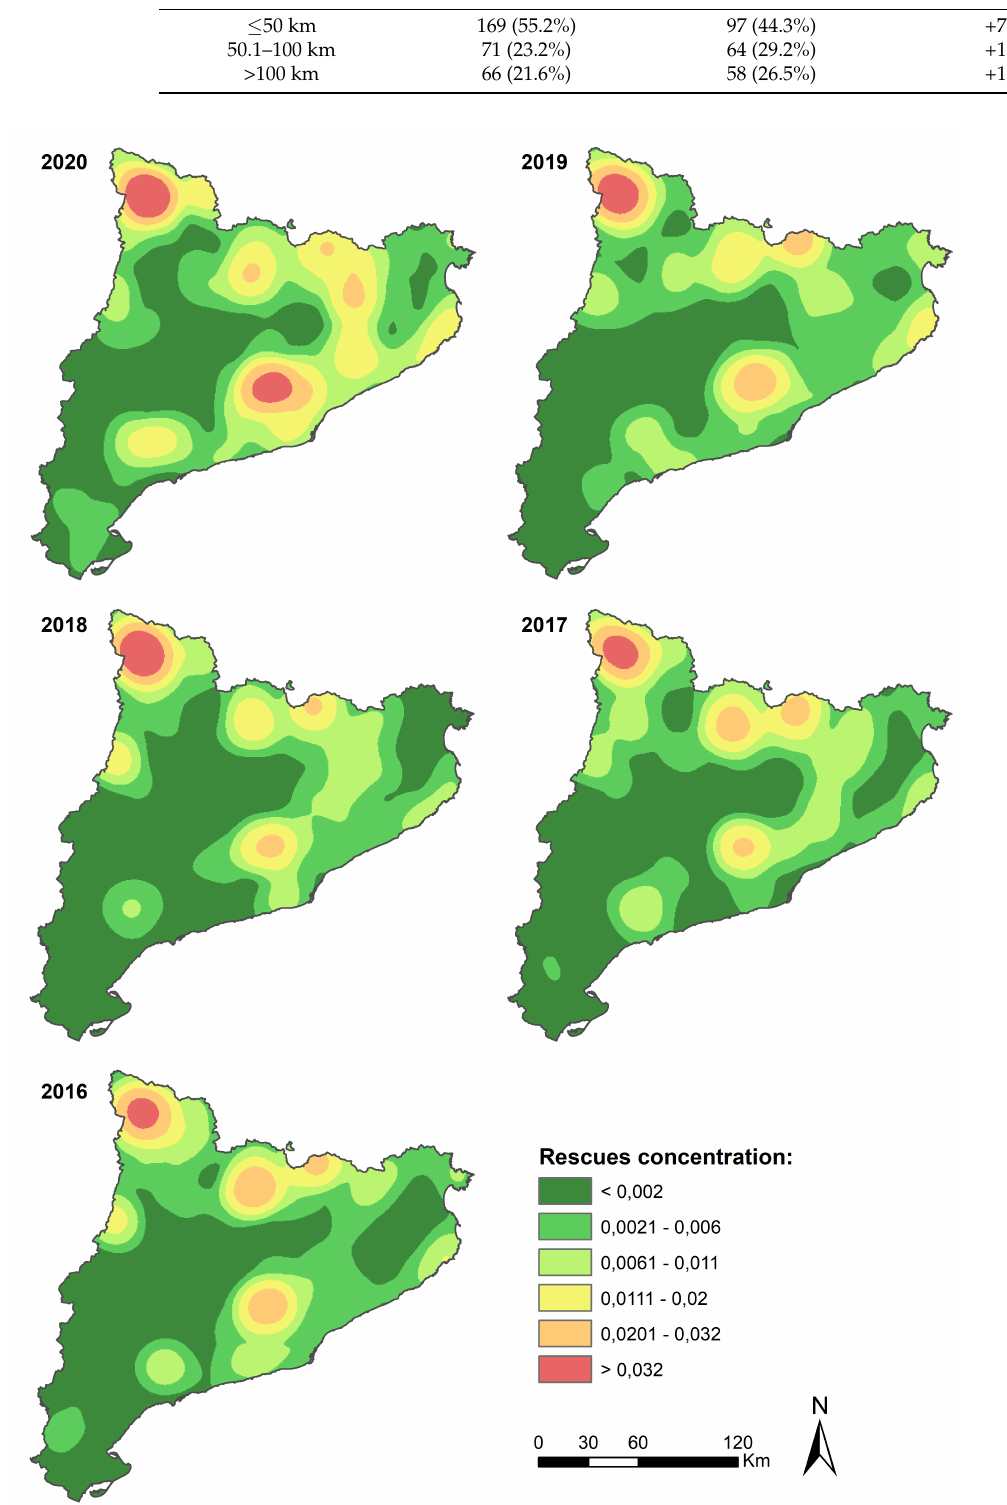
Figure 7. Spatial concentration of rescues.